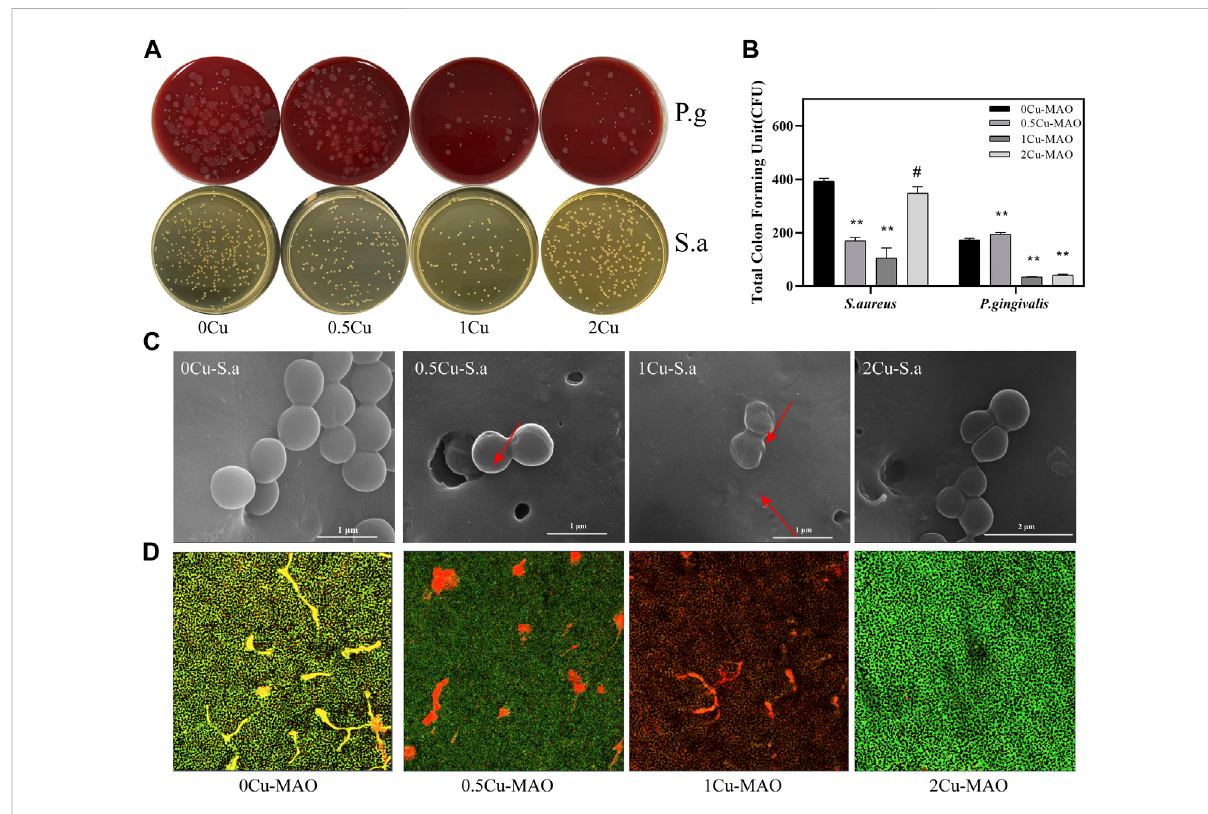
FIGURE 9 Antibacterial activities of Cu-doped coatings against S. aureus and P. gingivalis (A) ; CFU results after S. aureus and P. gingivalis were cocultured with the Cu-MAO coating for 24 h. Data are presented as mean ± SD; (** p < 0.01, vs. 0Cu-MAO group); (B) ; Live/Dead assay (D) and the corresponding SEM images (C) of S. aureus cultured on different surface after 24 h of